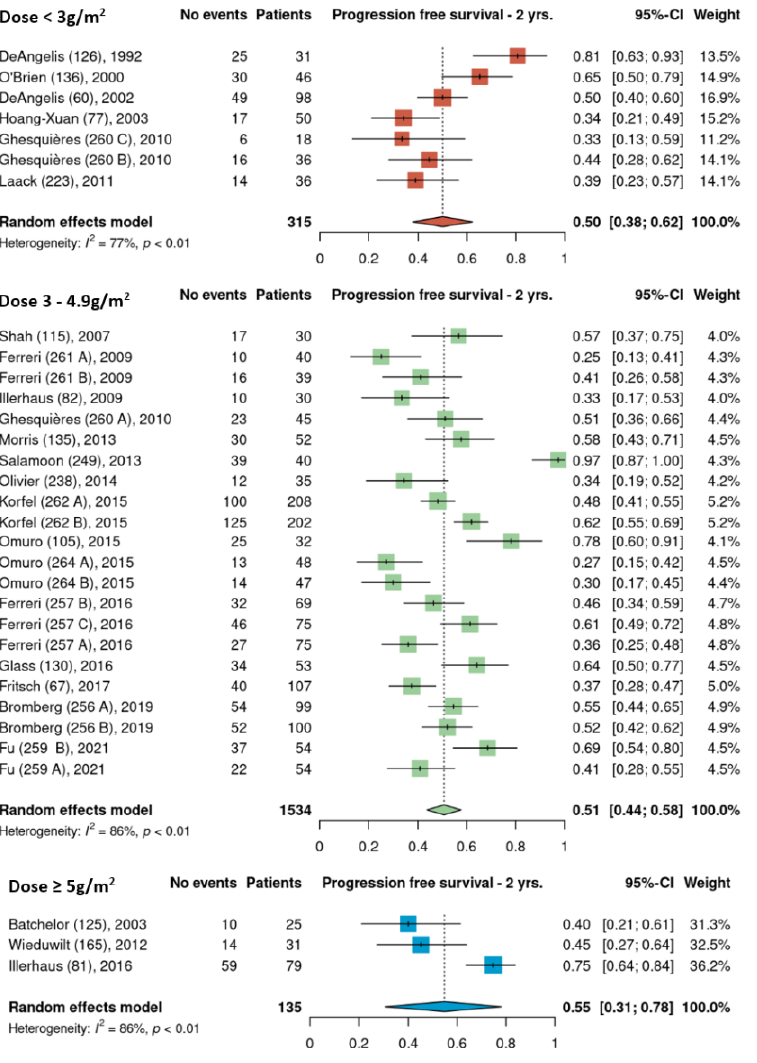
Figure 5. The 2-year progression-free survival of the different HDMTX dose categories [12,14,15,18,21,23,24,26 – 39,41,42].